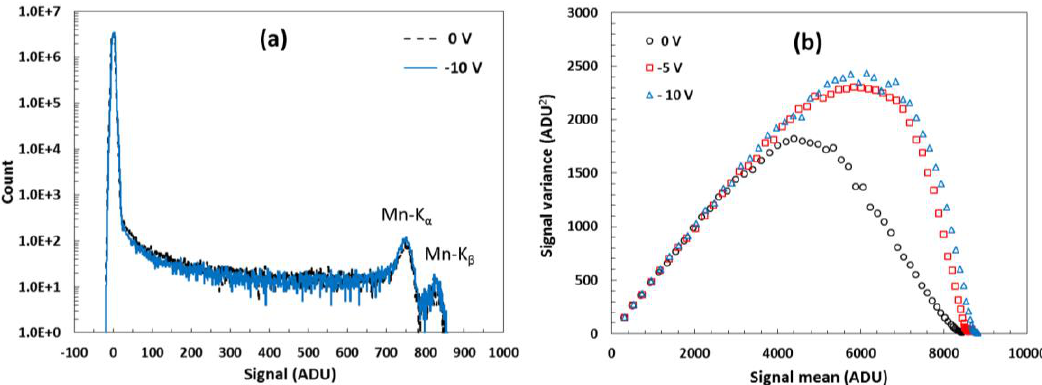
Figure 13. Data from a high V pin , deep DDE 10 µm pixel size variant #4: ( a ) 55 Fe X-ray spectrum taken with V BSB = 0 V and −10 V; ( b ) PTC of the same pixel array showing FWC limiting. One ADU is 160.2 µV.